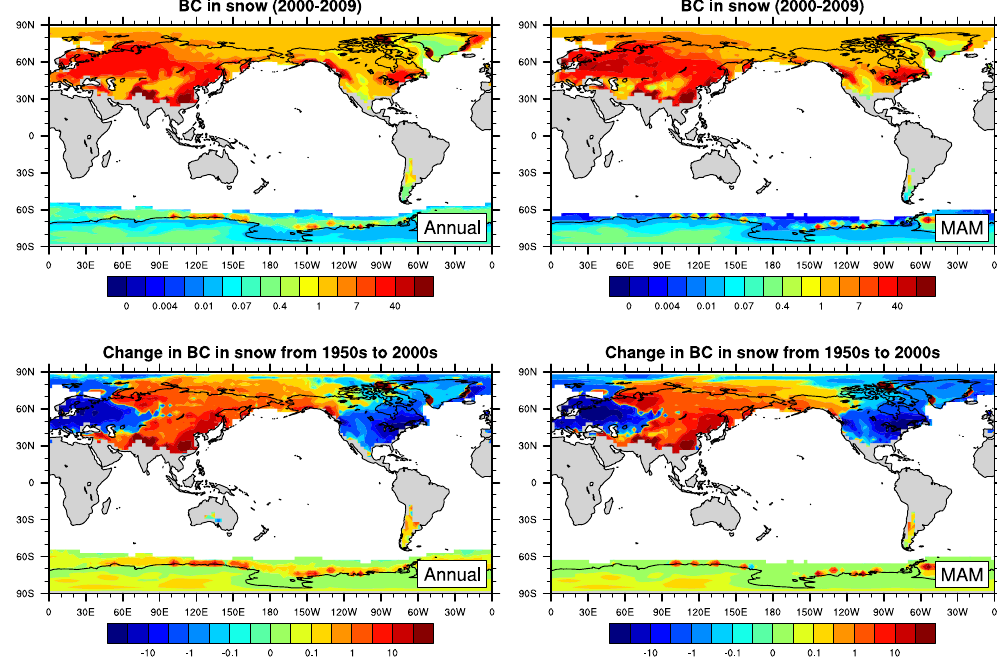
Figure 5. Annual mean (top left) and spring mean (top right) BC concentration in snow (mgm − 3 ) during 2000–2009 and annual mean (bottom left) and spring mean (bottom right) change in BC concentration in snow (mgm − 3 ) from the 1950s to